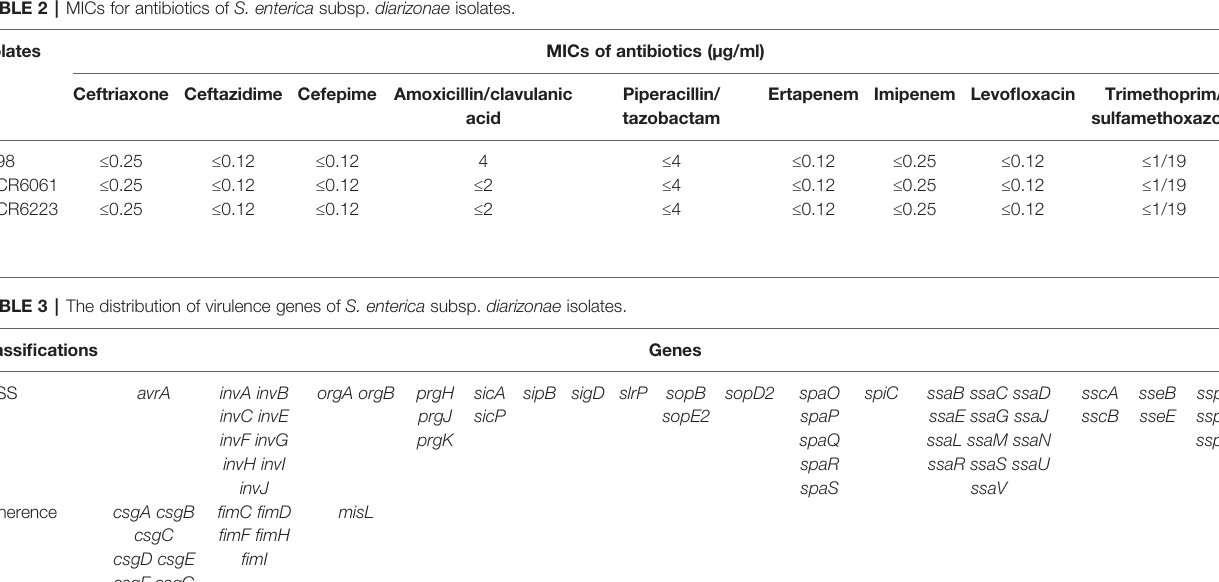
TABLE 2 | MICs for antibiotics of S. enterica subsp. diarizonae isolates. Isolates MICs of antibiotics (µg/ml)